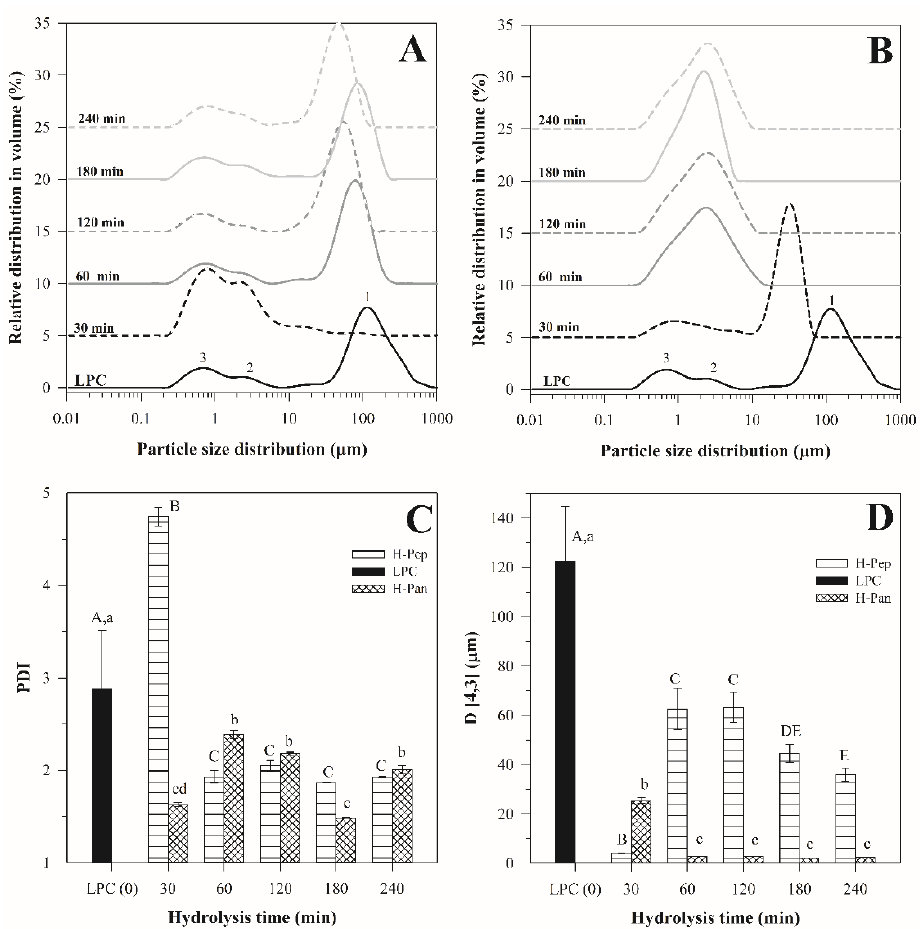
Figure 5. Effect of hydrolysis time and type of enzyme on the particle size distribution ( A , B ), polydispersity index (PDI, C ), and volume-weighted mean particle diameter (D [4,3], D ) of emulsions stabilized (pH = 7.0) with H–Pep ( A ) and H–Pan ( B ) obtained at different hydrolysis time. LPC, Leaf protein concentrate. Different letters indicate significant differences ( p < 0.05) between the hydrolysis time in a specified sample.